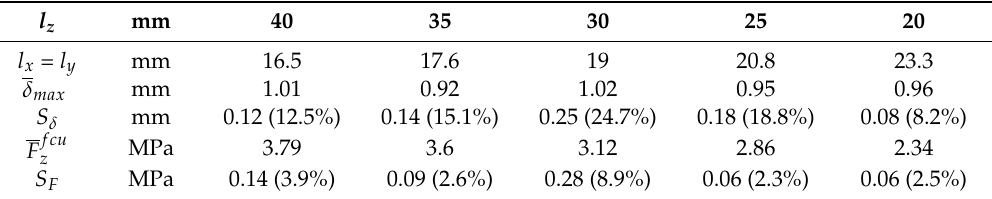
Table 4. Results of compression tests of honeycomb core structure.